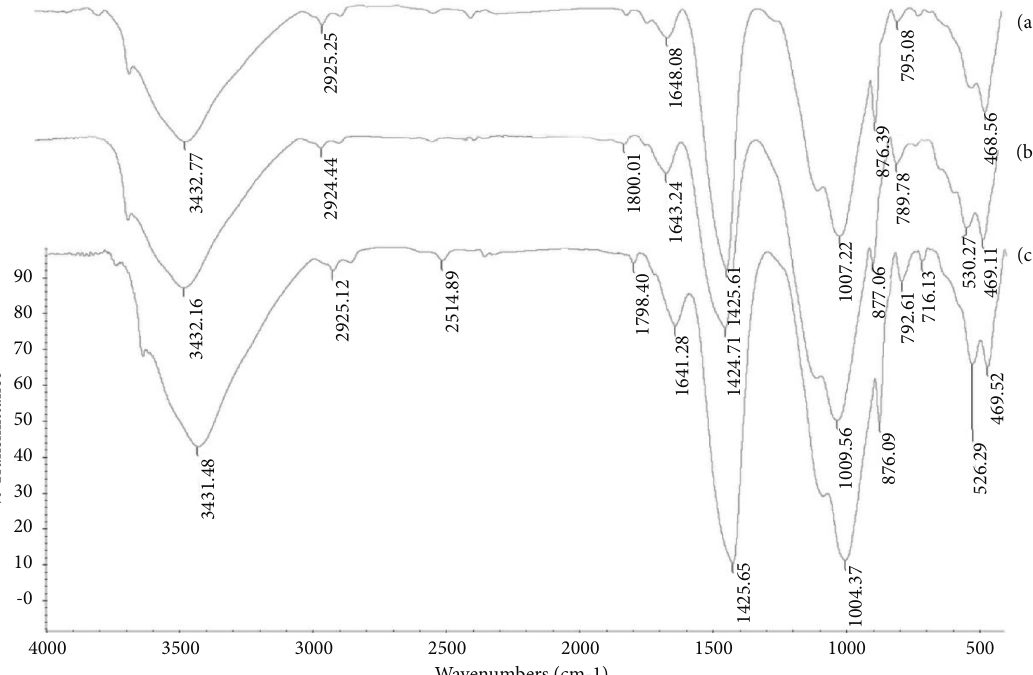
Figure 14: spectrum of (a) FT-IR of the control sample, (b) concrete containing 2% Al GO/Al 2 O 3